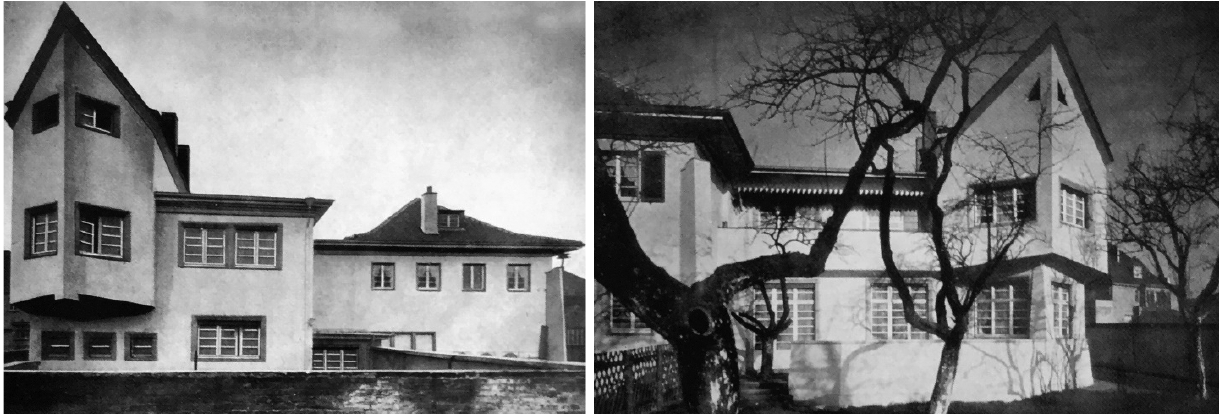
Figure 3. W. Riphahn, Haus Riphahn, Köln-Braunsfeld, 1923–1924, garden and front street view. Source: Fries (1927). shops of Köln-Merheim, the restaurant Bastei and vari- ous examples of housing construction in Köln-Braunsfeld (Läuferts, 2004, pp. 24–29; see Figure 3).